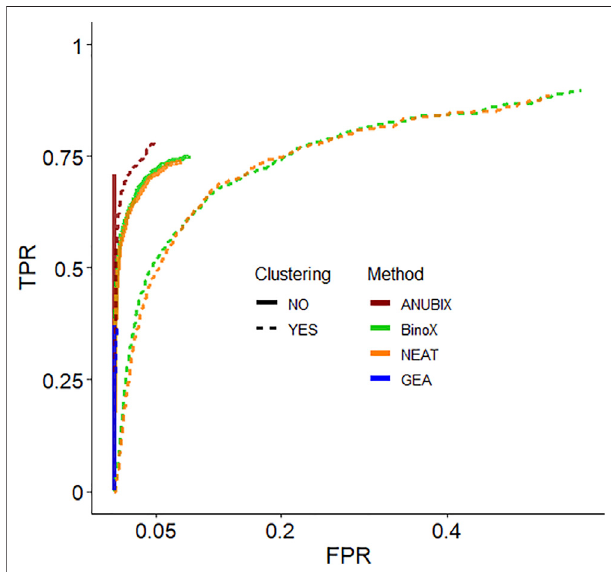
FIGURE 4 | Receiver Operating Characteristic (ROC) curves that measure the performance of each pathway analysis tool, with clustering (dotted lines) and without (solid lines). The used clustering algorithm was Infomap. Only the signi fi cantly enriched tests are shown (FDR < 0.05).